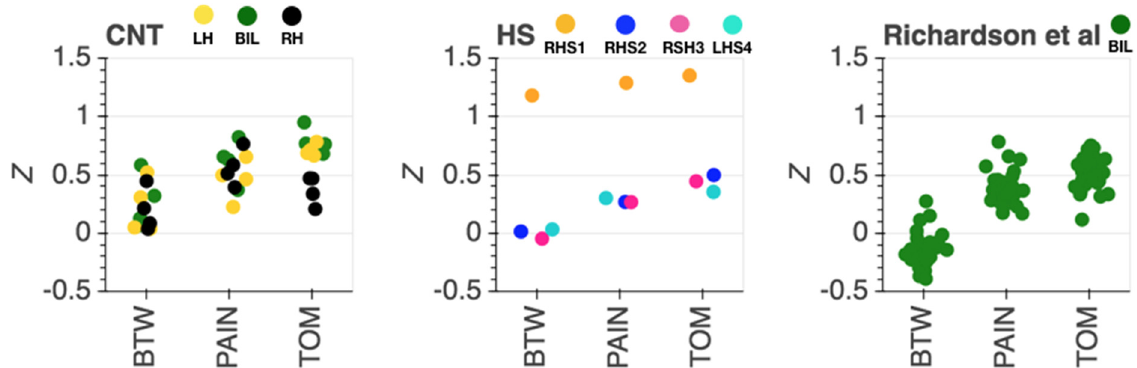
Figure 4. Strength of network connectivity (Fisher’s z) within (ToM, PAIN) and between (BTW) social brain networks for the hemispherectomy (HS, middle ), comparison s (CNT, left ) and a previously published independent dataset of comparison participants (Richardson et al., [7] right ). Each datapoint corresponds to one subject. For CNT, type of ROI is color coded (bilateral: green; LH: yellow; RH: black), for HS, subjects are color coded (RHS1 orange, RHS2: blue, RHS3: pink, LHS4 turquoise), for Richardson et al. [7] comparison data, all data are from bilateral (green) ROIs per subject.